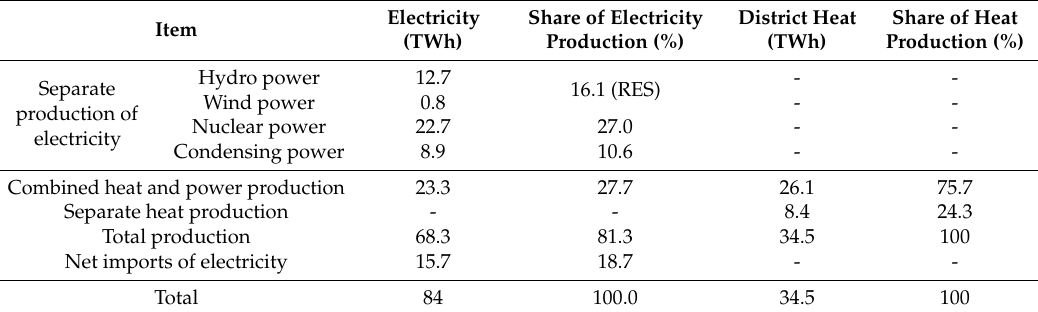
Table 5. Electricity and heat production by production mode in 2013 by Statistic Finland